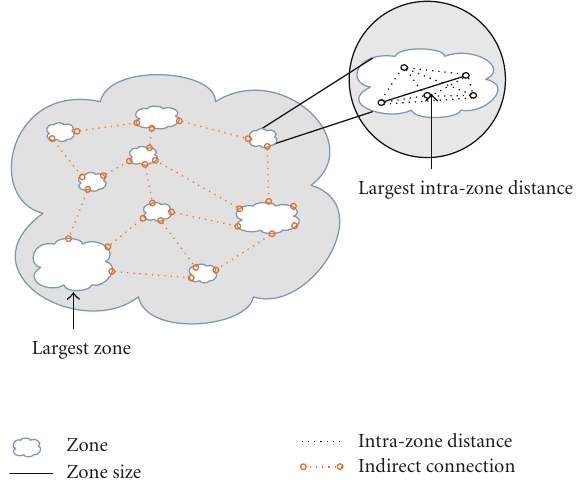
Figure 1: Schematic representation of zones in a network. Zones are represented by clouds. The distance between any two nodes among the same zone is noted as intra-zone distance . The largest intra-zone distance is the zone size , represented with a plain